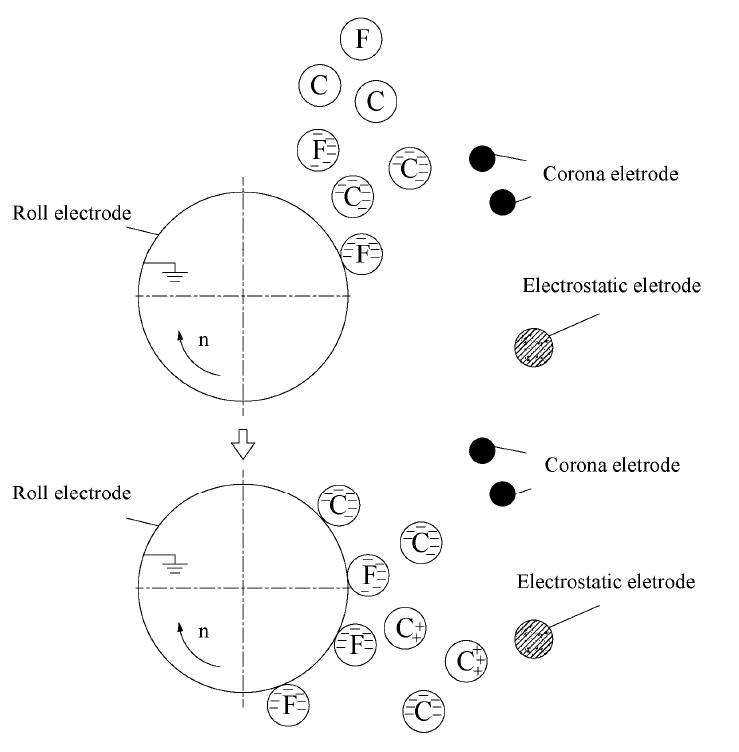
Figure 6. Model for the charging process. C: unginned cotton and F: residual film.